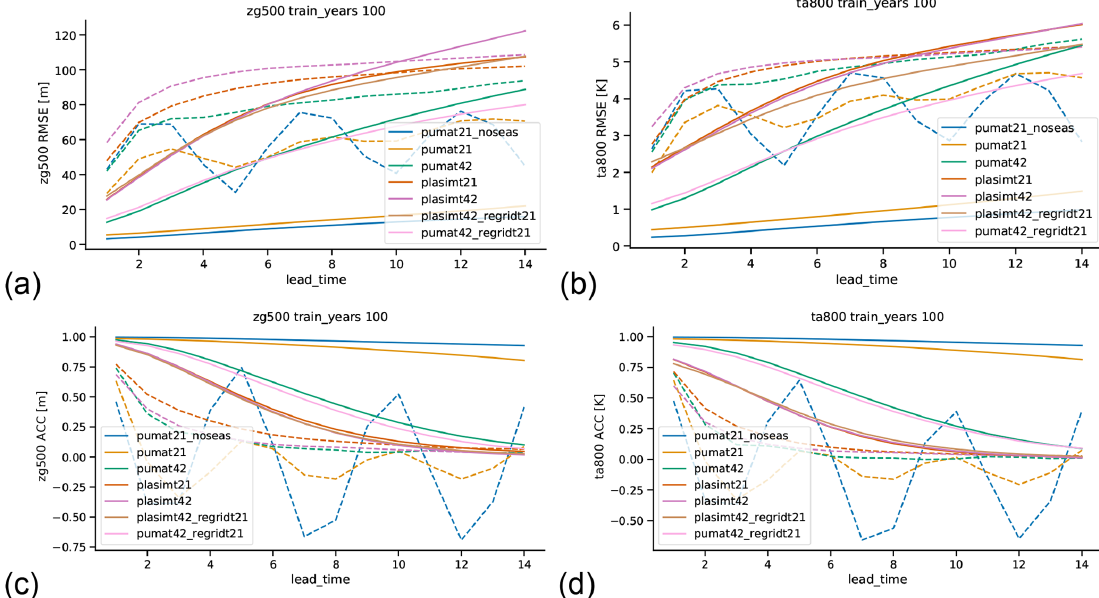
Figure 3. Root mean square error (RMSE) and anomaly correlation coefficient (ACC) of 500hPa geopotential height (a, c) and 800hPa temperature (b, d) for network forecasts (solid lines) and persistence forecasts (dashed lines) for all models for different lead times (in days). All forecasts are based on 100 years of training data.